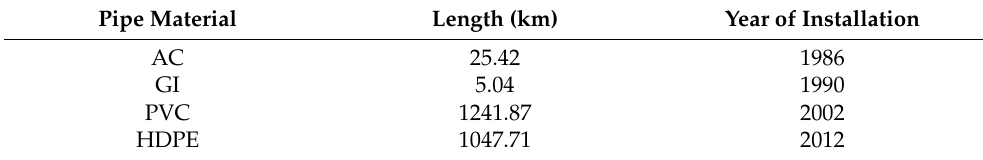
Table 1. Water distribution pipe material in the study area.